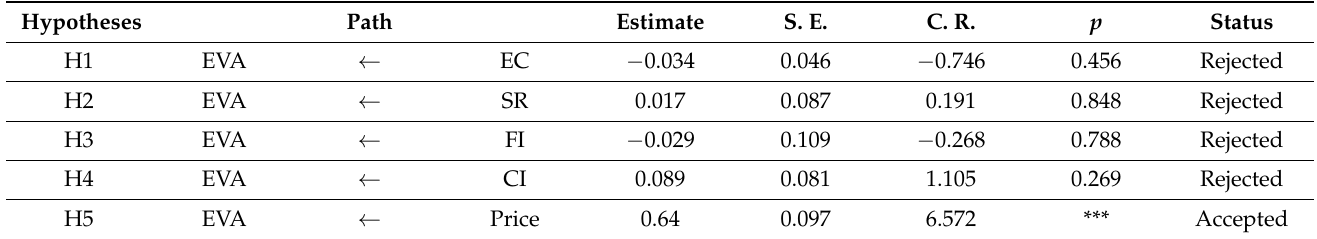
Figure 3. Structural Model. Table 6. Hypotheses